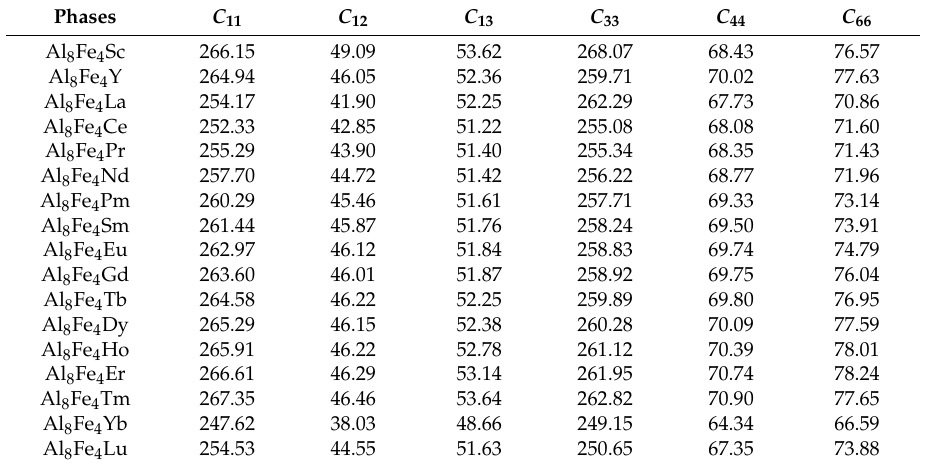
Table 2. The calculated elastic constants of Al 8 Fe 4 RE intermetallic compounds (IMCs) (unit in GPa).